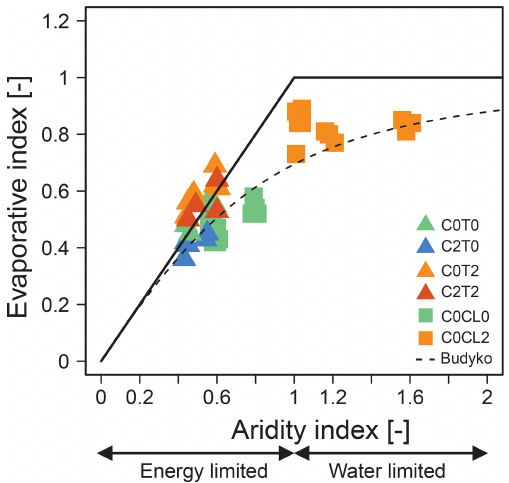
Figure 2. Budyko plots comparing the two approaches (Lysi-T- FACE – C2T0, C0T2, and C2T2; TERENO-SOILCan – C0CL2) to the ambient reference of the two approaches (Lysi-T-FACE – C0T0; TERENO-SOILCan – C0CL0) during 2015–2018. The aridity in- dex and evaporative index are the ratios of the cumulated yearly grass reference evapotranspiration and actual evapotranspiration to the incoming atmospheric water (i.e. precipitation and non-rainfall water). The dotted curve shows the Budyko curve ( ω = 2 .